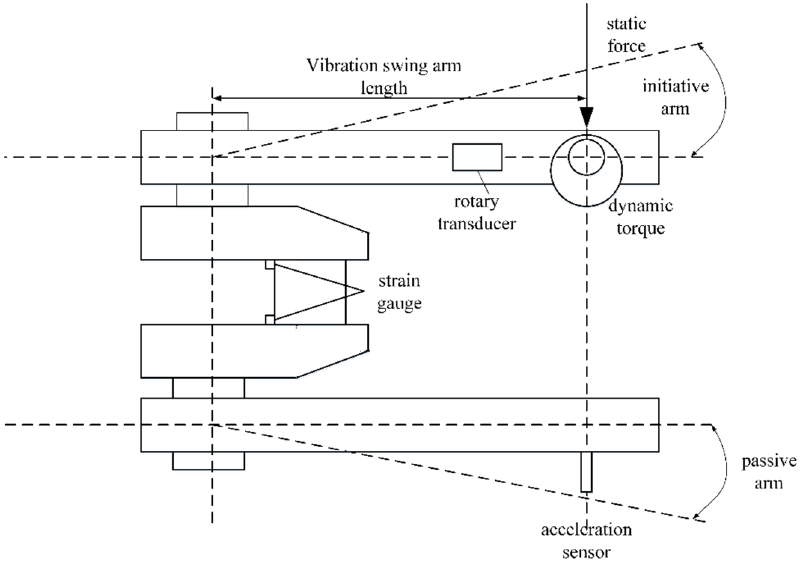
Figure 1. The structure diagram of the bending fatigue experiment equipment.